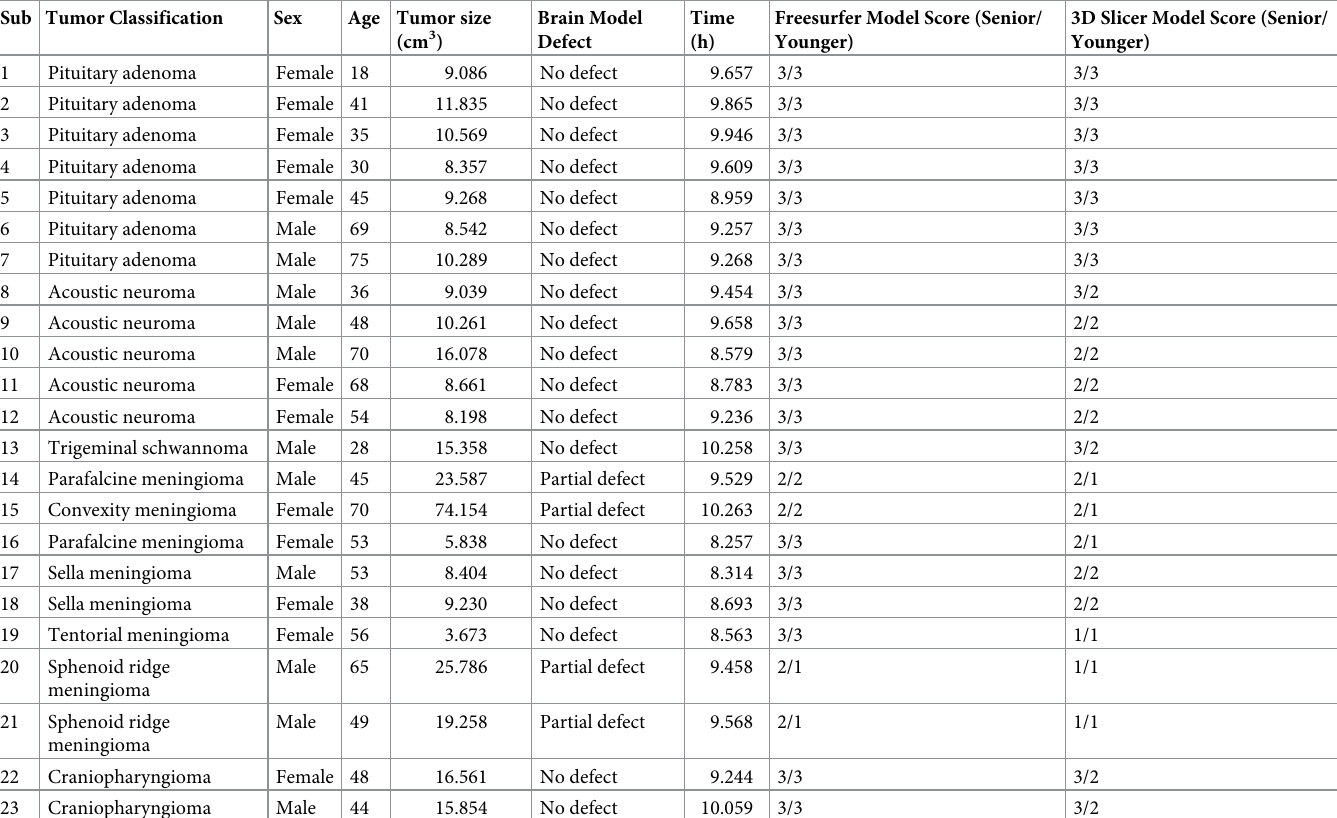
Table 2. Summary of the